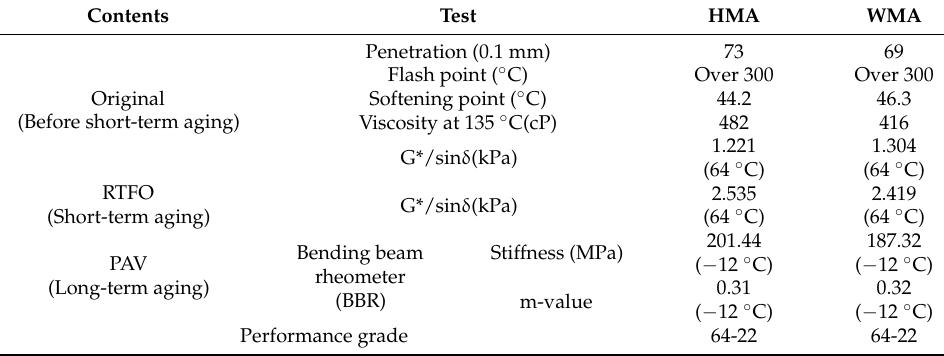
Table 1. Test variables and designation of specimens.